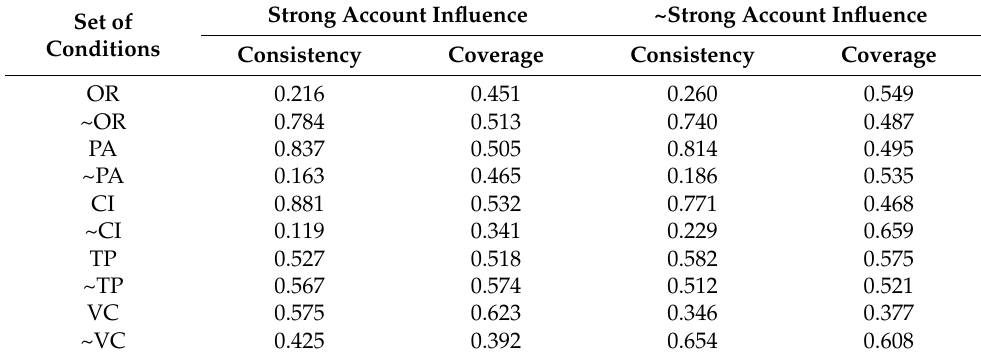
Table 3. Necessary conditions